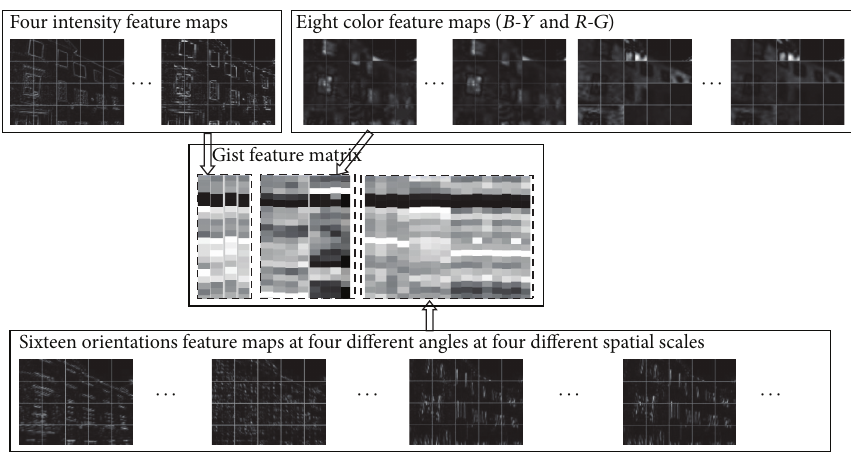
Figure 4: The process of building a gist feature matrix. We take the mean of each subregion in each assembled feature map to produce 20 values for a gist column. In total, 28 gist columns are computed. Then all the gist feature columns are combined into a gist feature matrix.